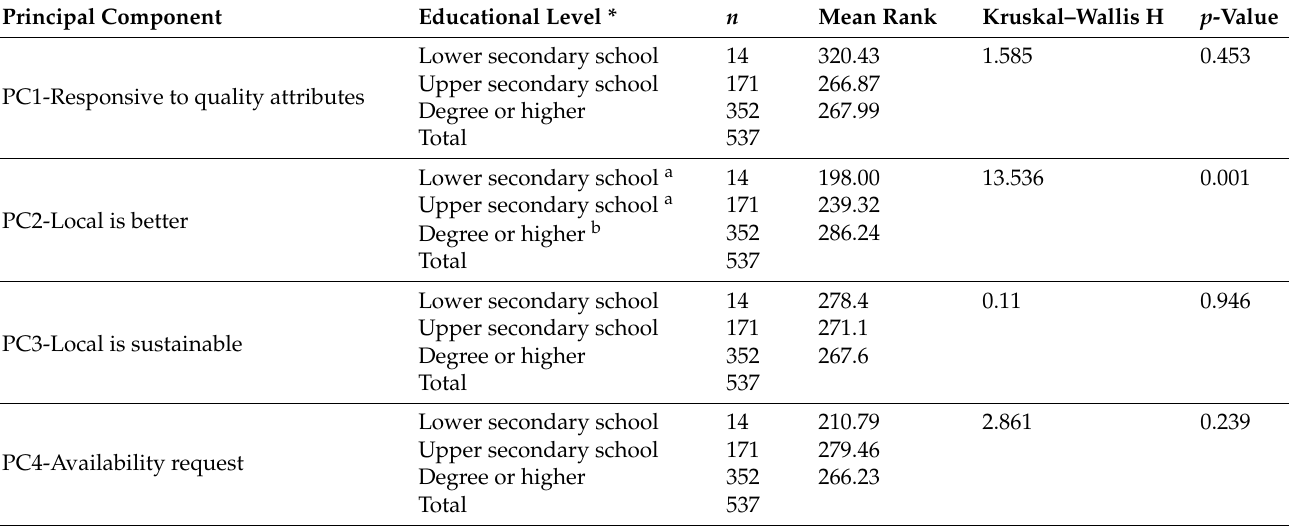
Table 6. Effect of educational status on the principal components’